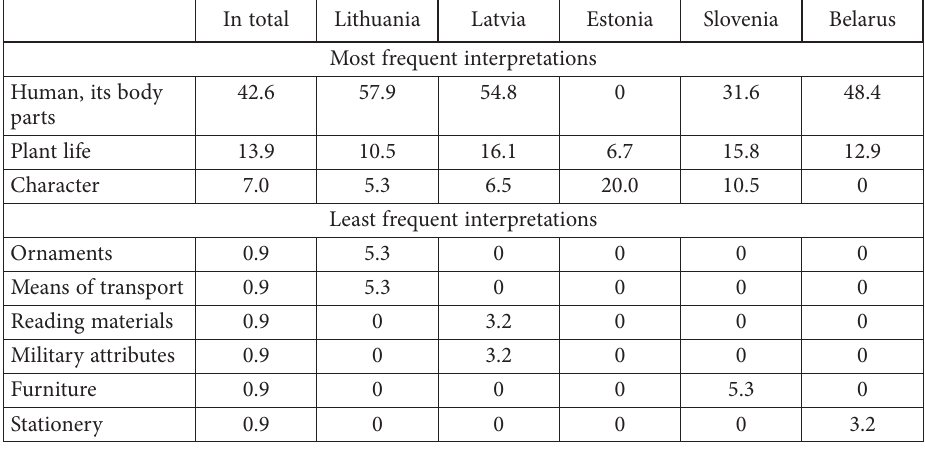
Table 10. Interpretations of Fragment 5 (%) (source: created by authors) In